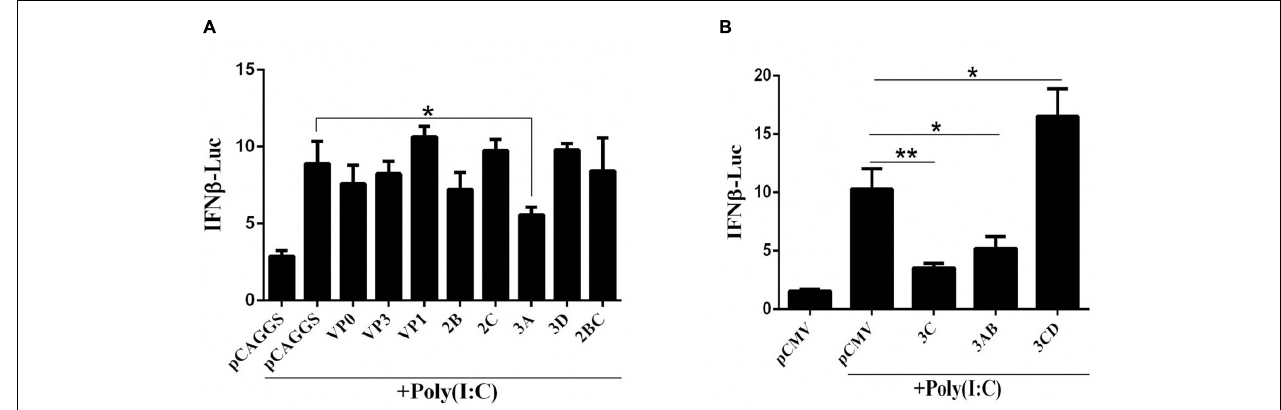
FIGURE 1 | (A,B) The effect of DHAV-1 viral proteins on the IFN- β signaling pathway induced by poly(I:C). pCAGGS, pCAGGS-VP1-Flag, pCAGGS-VP0-Flag, pCAGGS-VP3-Flag, pCAGGS-2B-HA, pCAGGS-2C-HA, pCAGGS-3A-Flag, pCAGGS-3D-Flag, pCAGGS-2BC-HA, pCMV, pCMV-3C-HA, pCMV-3CD-HA, and pCMV-3CD-HA were cotransfected into DEFs with IFN- β pro-Luc, poly(I:C), and pRL-TK. The transfection ratio of other plasmids was 1:1:1, except for the reference plasmid, pRL-TK. The amount of pRL-TK used for transfection was 1/20 that of IFN- β pro-Luc. Cell samples were collected 36 h after transfection, and IFN- β promoter activity was detected using a dual-luciferase reporter system. * P < 0.05, ** P < 0.01, compared with control group.